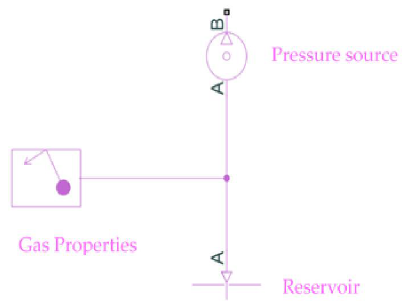
Figure 2. The SimScape model of the supply unit.